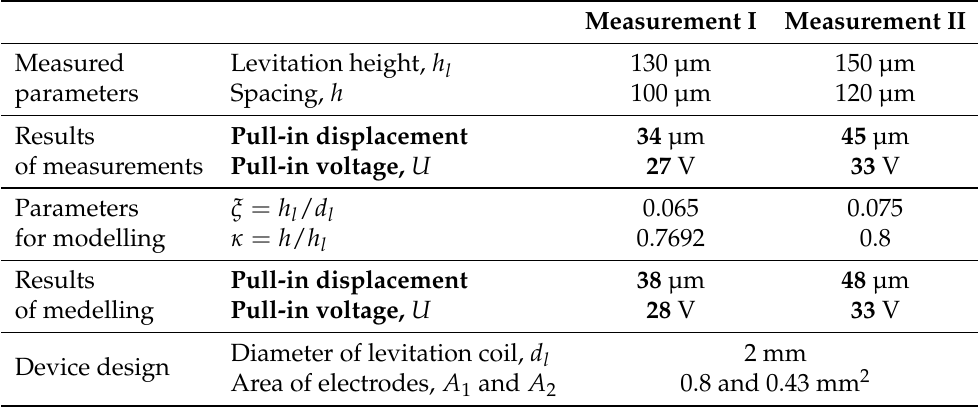
Table 1. Results of measurements and modeling of the static